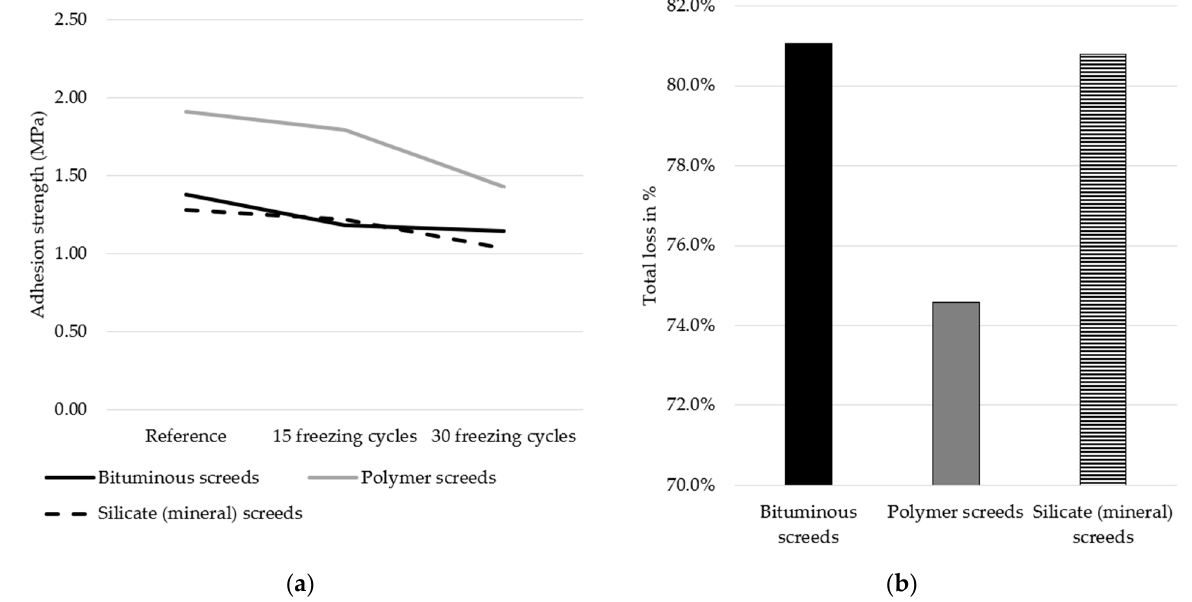
Figure 18. ( a ) Average adhesion strength without the influence of the substrate; ( b ) average residual strength after 30 freezing cycles without the influence of the substrate [%].